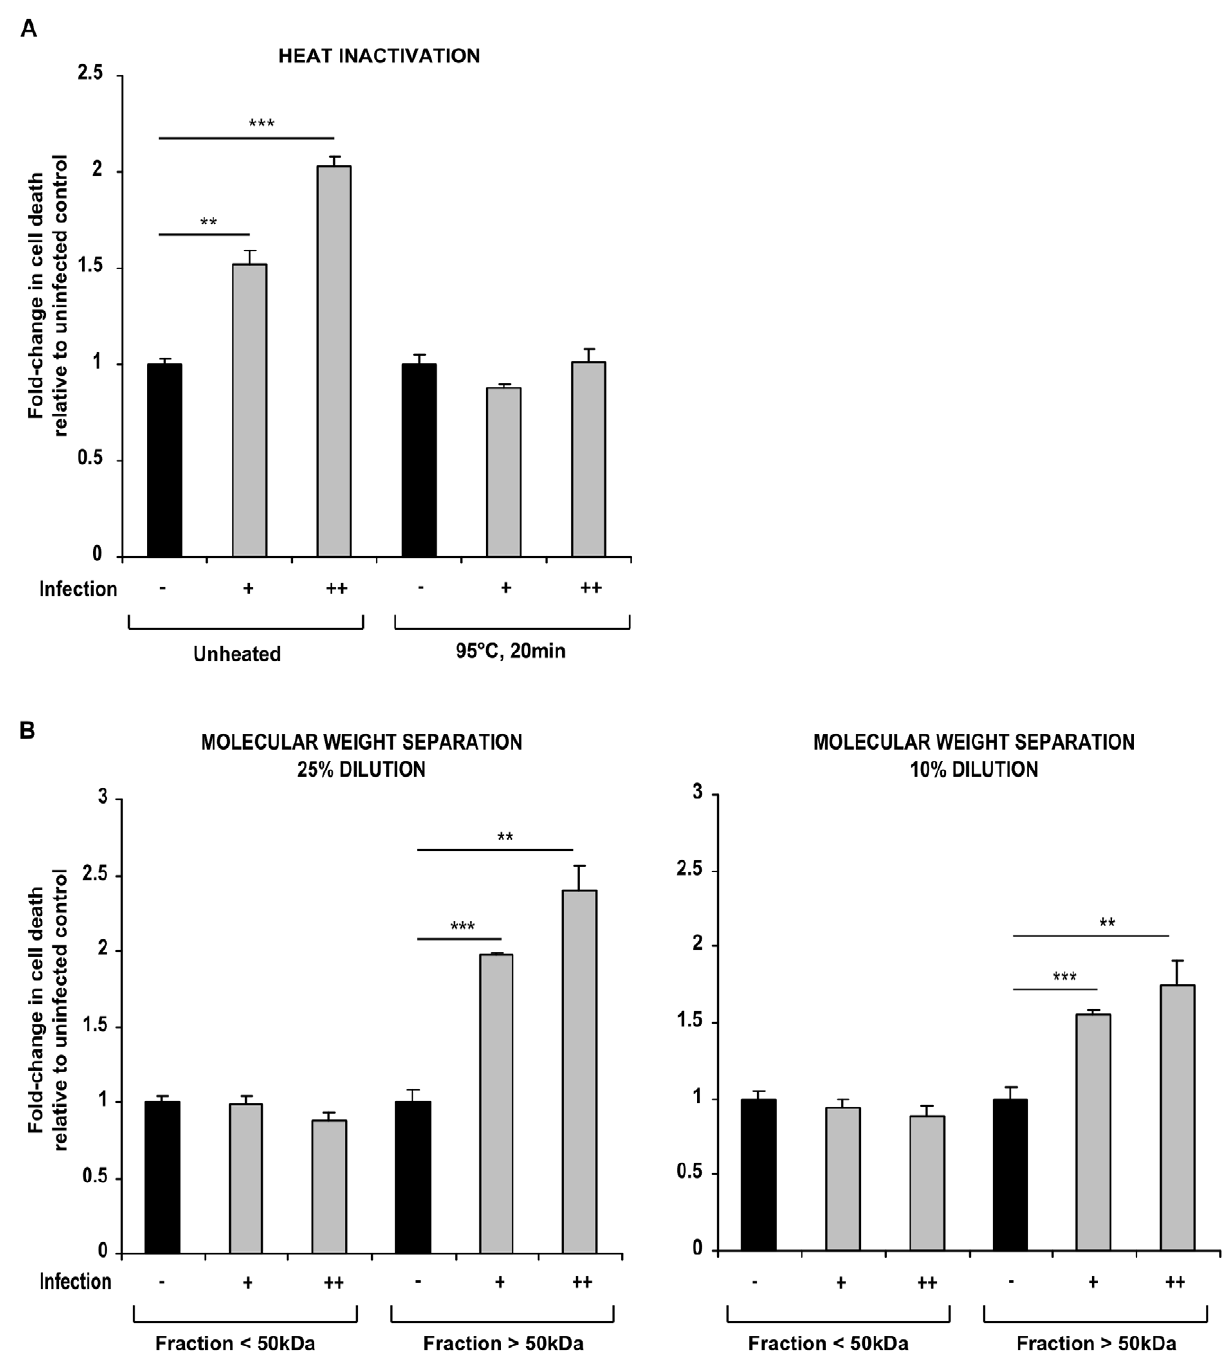
Figure 6. T cell death in M.tuberculosis -infected macrophage culture supernatants is mediated by heat-sensitive factor(s) greater than 50 kDa in molecular size. (A) Heat inactivation (95 u C, 20 min) of supernatants from low MOI and high MOI-infected macrophages (shaded bars, infection + and ++ respectively) inhibited induction of Jurkat T cell death. (B) Death-inducing factor(s) in infected macrophage supernatants were retained in the . 50 kDa fractions following molecular size separation, and killed Jurkat T cells in a dose-dependent manner (25% and 10% dilution). Data shown in each panel are from one representative experiment, showing fold-change in cell death 6 SEM in low MOI and high MOI- infected macrophage supernatants (shaded bars, infection + and ++ , respectively) relative to uninfected control (closed bars), from incubations performed in triplicate. Each experiment was repeated a minimum of three times. **= p , 0.01, ***= p , 0.001, Student’s t test relative to uninfected control. doi:10.1371/journal.pone.0038488.g006 Secondly, supernatants from infected macrophages were positive controls, 1 m M staurosporine induced 59.45 6 0.97% cell applied to T cells in the presence of TNF- a blocking antibody, death, which was significantly (p , 0.001) mitigated by coincuba- at a concentration of 5 m g/ml, or isotype IgG at the same tion with 20 m M Z-VAD-FMK, to 28.14 6 1.35% (fig. 5D).